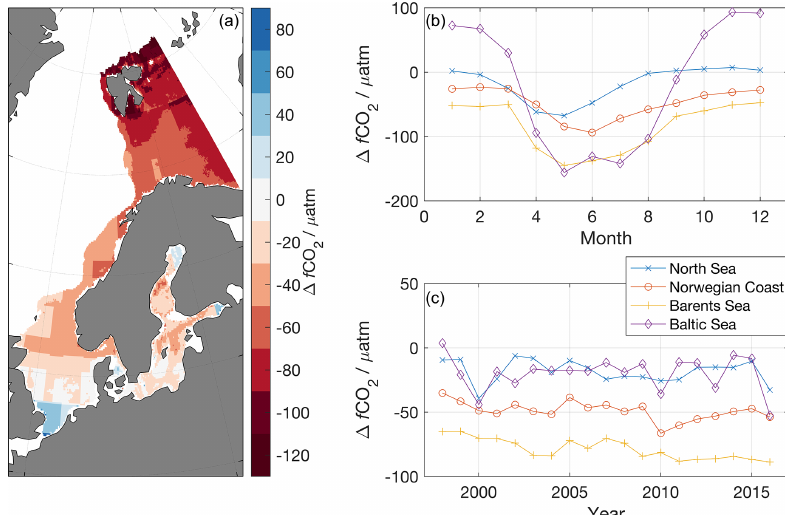
Figure 12. The average air–sea CO 2 disequilibrium over the period 1998–2016 ( a , red colors indicate average undersaturation, while blue colors indicate average oversaturation). For every region average disequilibria are shown as seasonal averages (b) and time series of annual disequilibria (c) . Blue line: North Sea; red line: Norwegian Coast; yellow line: Barents Sea; purple line: Baltic